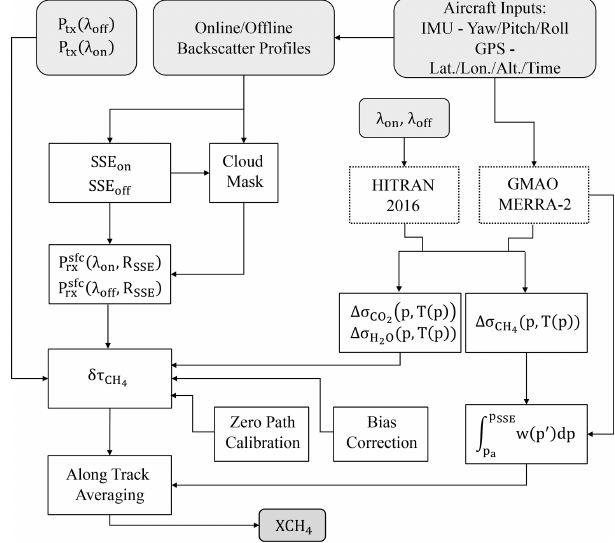
Figure 5. Processing flow for the HALO IPDA XCH 4